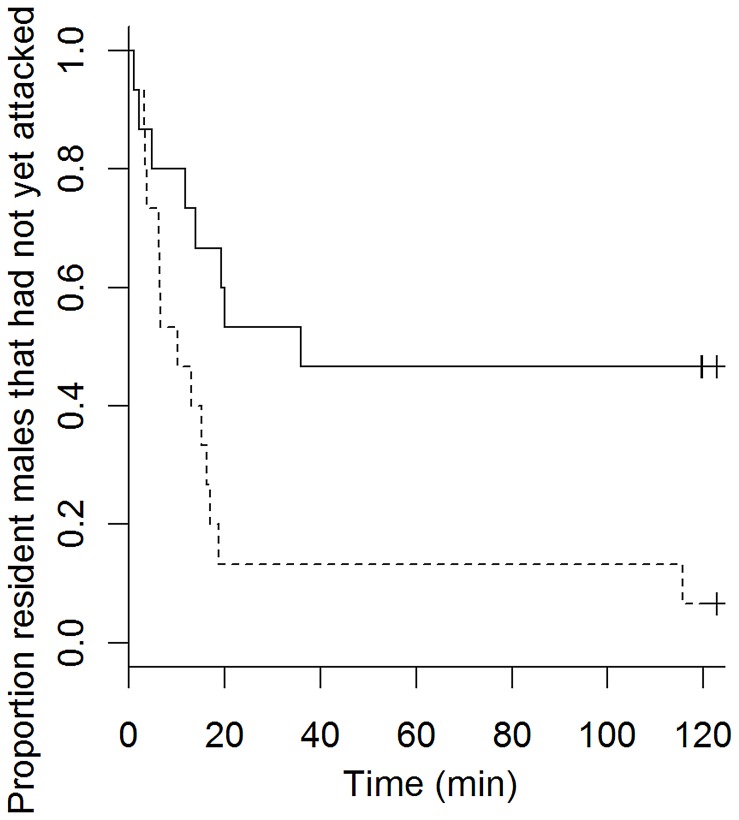
Kaplan-Meier survival curves for time to first attack after dividing resident males into large and small individuals.Solid line: resident males that were larger than the median length (TL = 62.2 mm). Dashed line: resident males smaller than median length. Crosses (+) indicate censored data.